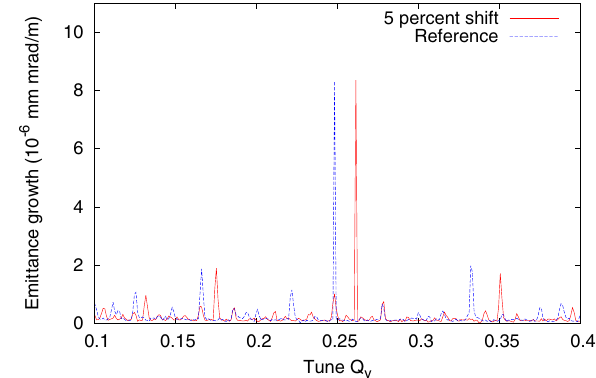
FIG. 8. Emittance growth rate for different vertical tunes Q ≃ 1 . 001 . The tune Q while Q is changed systematically in steps , x y y of Δ Q ¼ 0 . 001 . The integration length is changed, compared to the blue reference line, by a factor of 0.95 (red line).